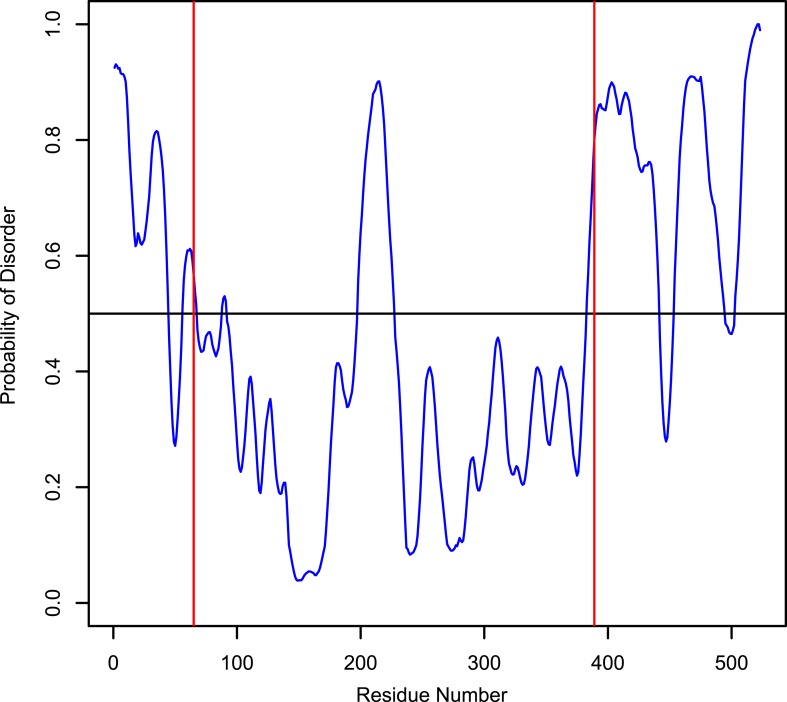
Disorder probability of human LIC1.The Protein Disorder Prediction System (PrDOS) (Ishida and Kinoshita, 2007) was used to assess the probability of disorder of full-length human LIC1. The red lines, at residues 65 and 389, indicate the approximate range of where the G domain exists.